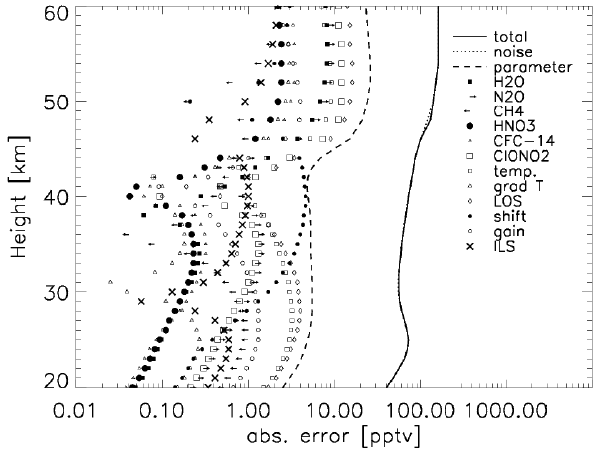
Fig. 6. Typical MIPAS Averaging Kernel ( A ) in the tropics for H 2 O 2 . Altitudes marked for better illustration: 19km (turquois), 27km (green), 35km (yellow) and 43km (red). The diamonds indi- cate the altitude the averaging kernels refer